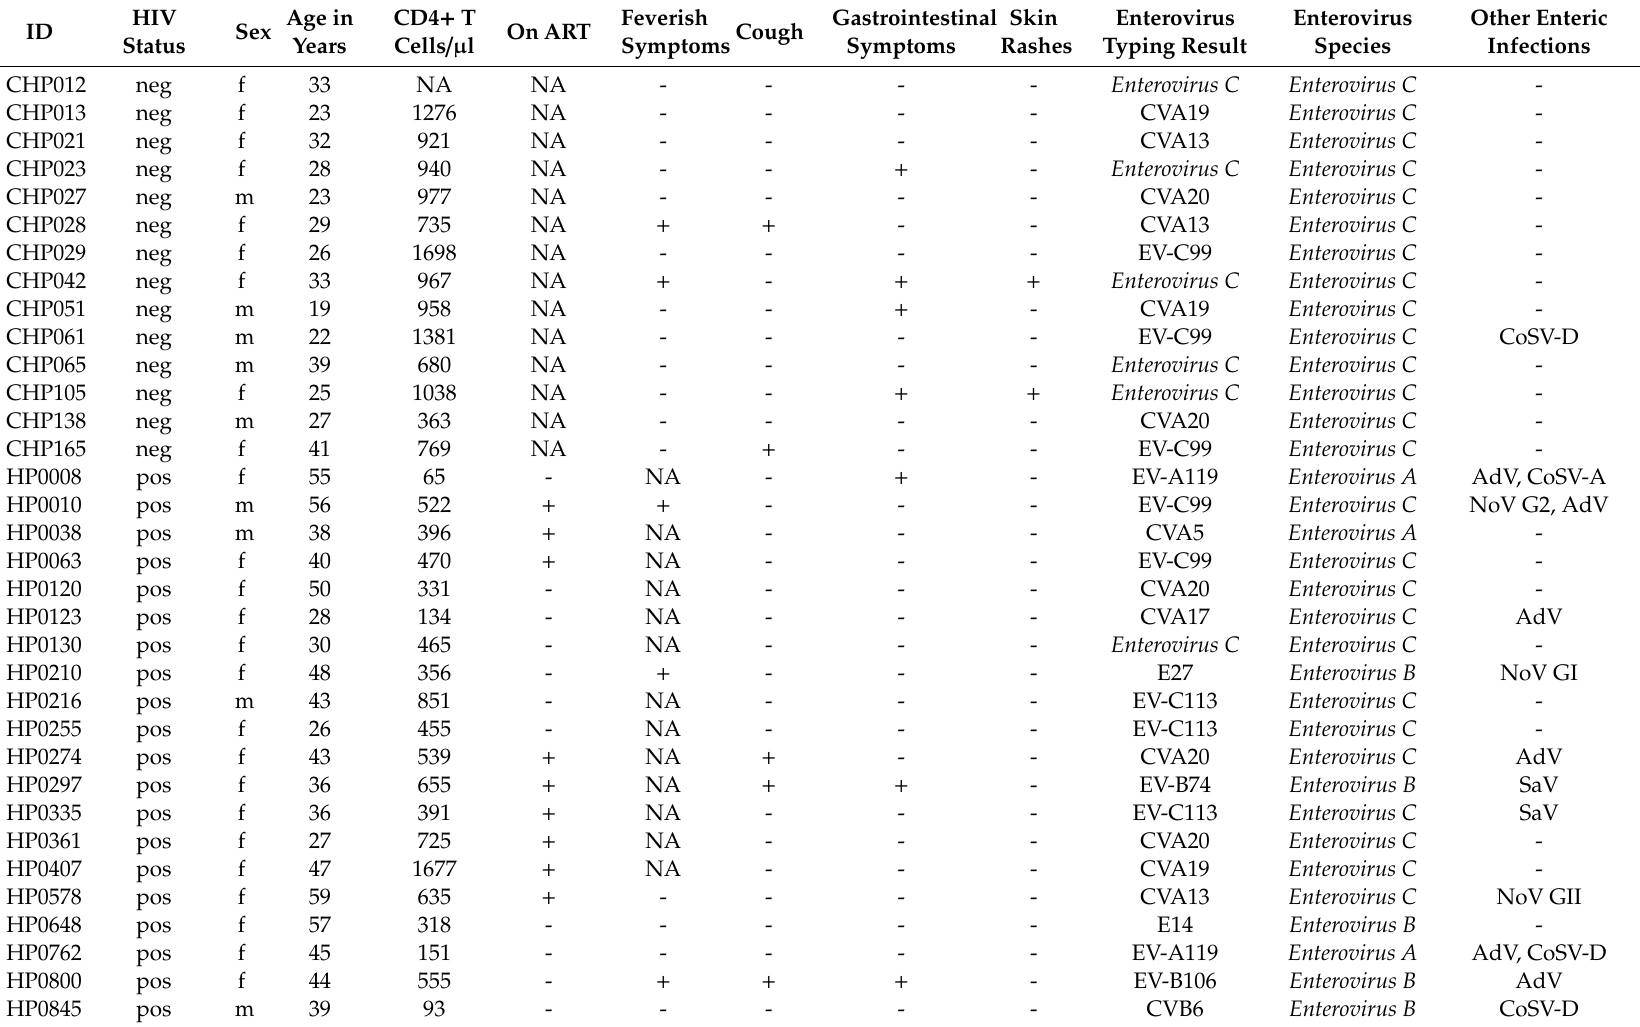
Table 2. Characteristics, clinical features and enterovirus typing results of enterovirus-positive adults living in